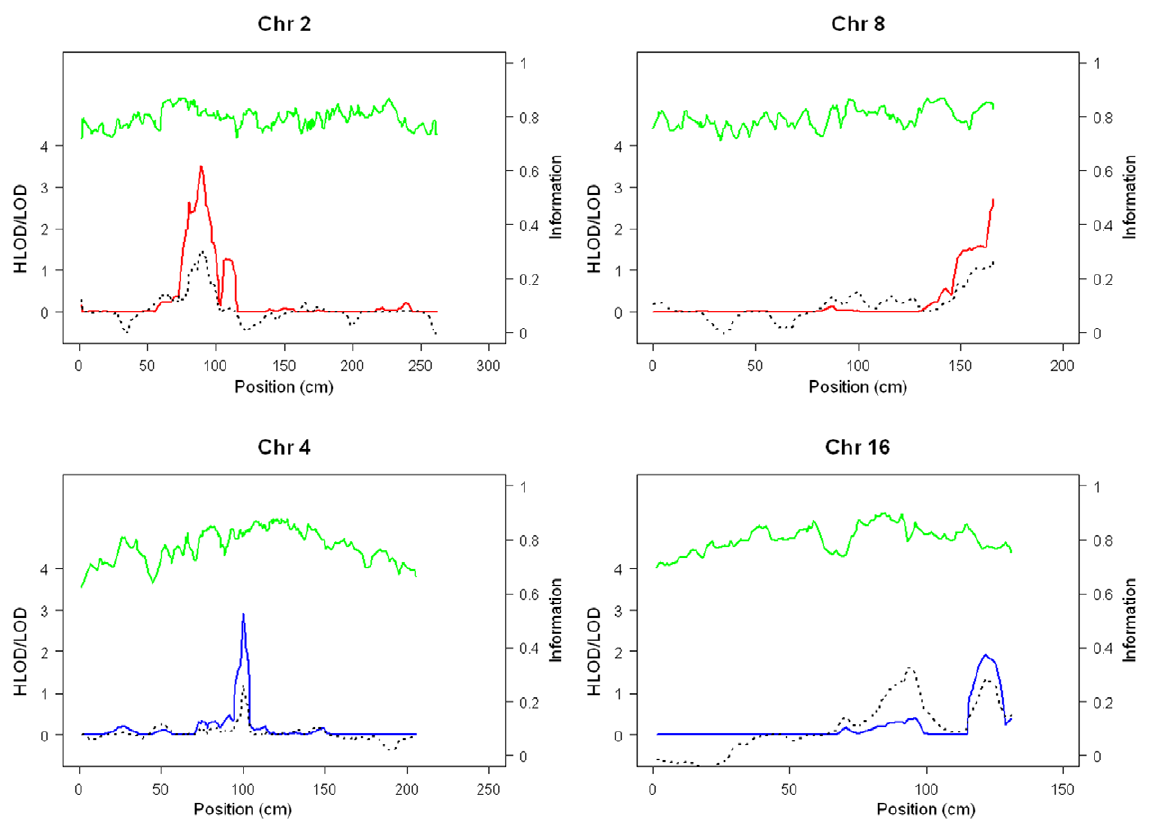
Figure 1. Genome-wide linkage results. Genomic position is shown on the horizontal axis; HLOD(parametric Model)/LOD(non-parametric model) score on the left vertical axis.; Information content on the right vertical axis. Red line indicates results under a recessive model; blue line indicates a dominant model, dashed line indicates nonparametric analysis, and green line indicates information content. doi:10.1371/journal.pone.0029747.g001 PLoS ONE |